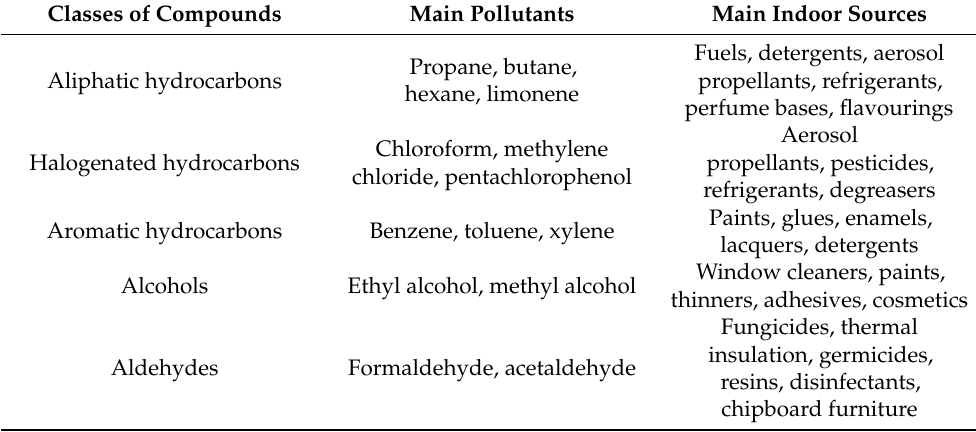
Table 2. Indoor VOCs and main